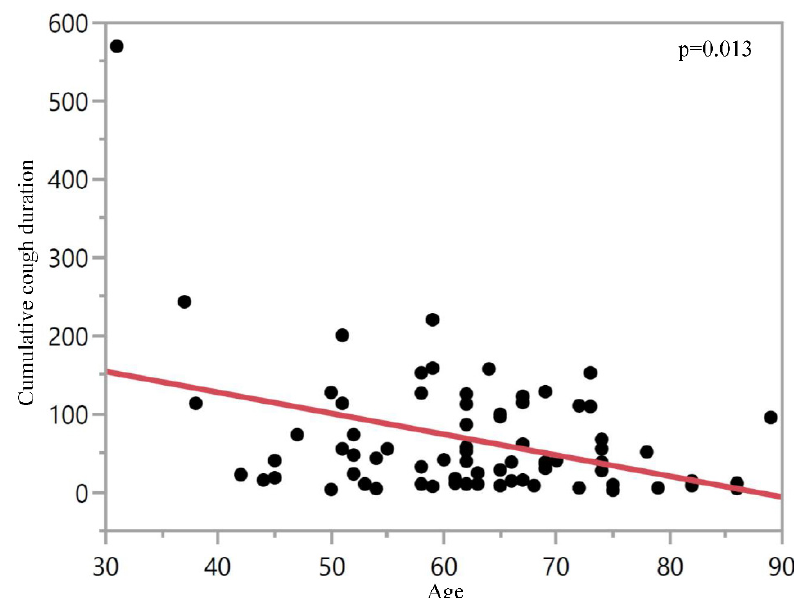
Figure 3. Cumulative cough duration in seconds during the ten minute post-procedural observation period with regard to patient age. Shown data cumulate both groups (S1 and S2, independent of application of LAP) with one dot for each patient.